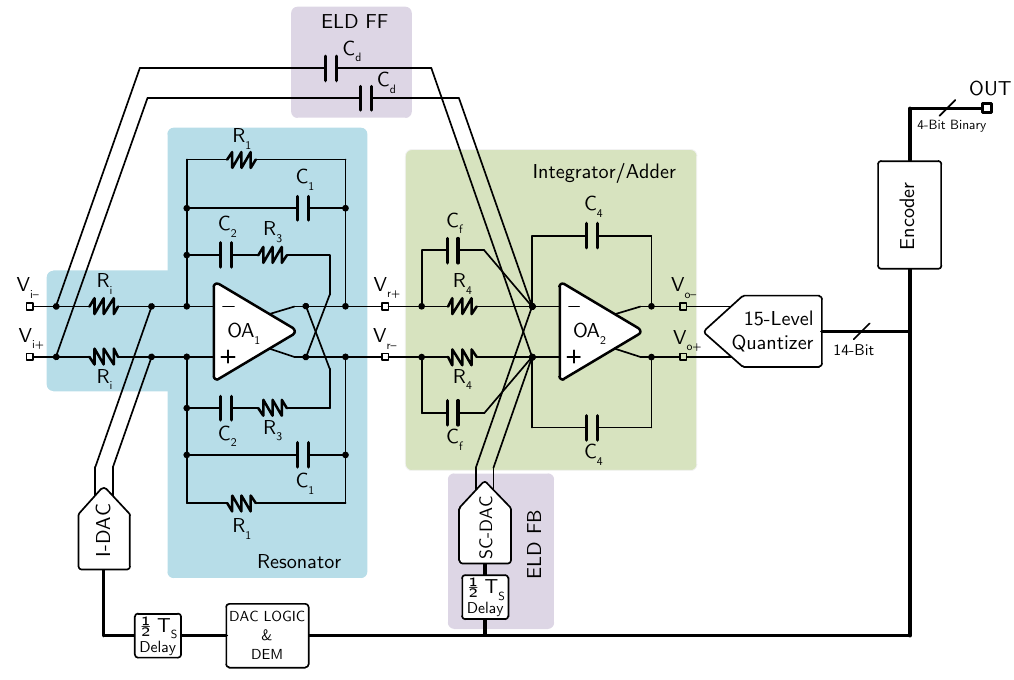
Figure 19. Schematic of the active-RC implementation of the third-order CT ΣΔ modulator (example 4).